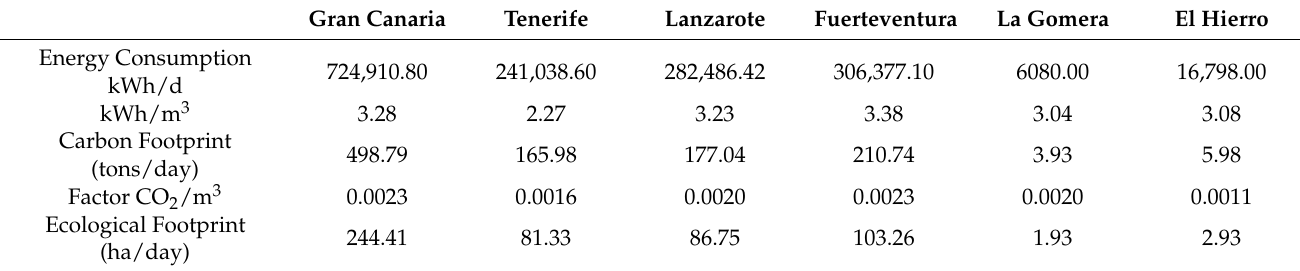
Table 18. Energy consumed, carbon footprint, ecological footprint, and carbon factor per island and cubic meter produced in Canaries. Year